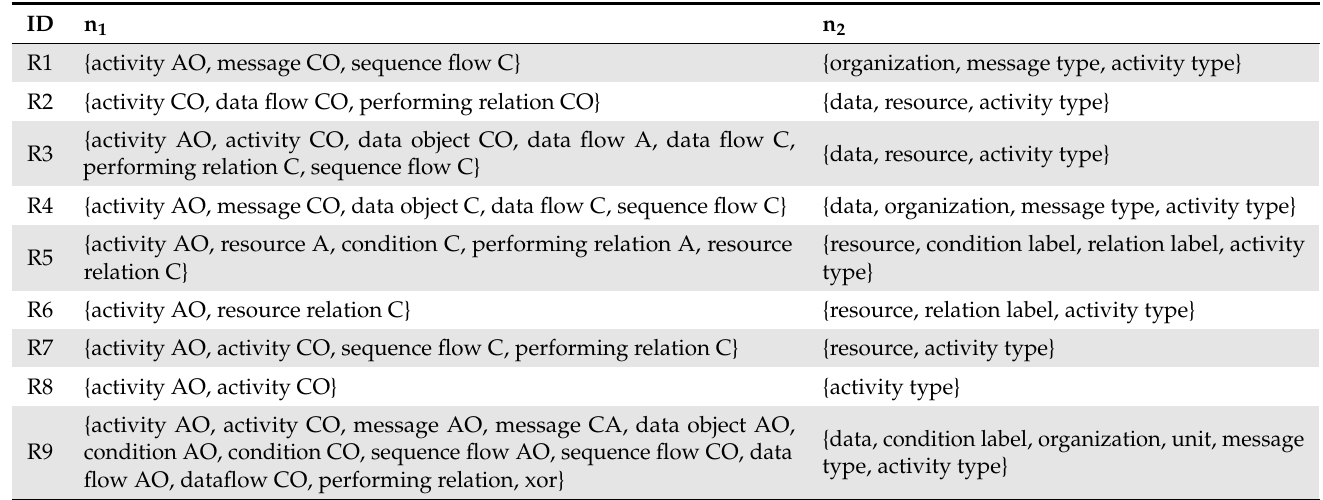
Table A13. Definitions on eCRG .